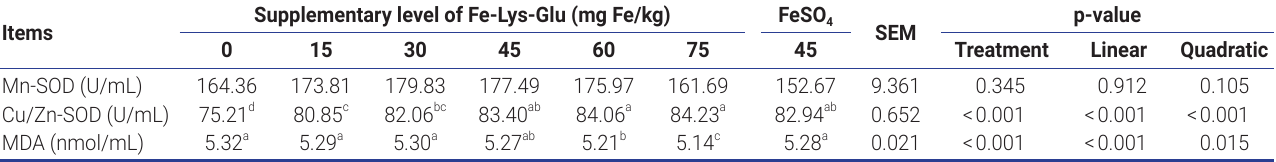
Table 6. Effects of dietary Fe-Lys-Glu supplementation on serum antioxidant capability of laying hens Items